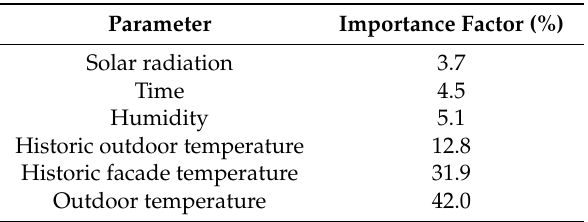
Table 3. Analysis of the relevance of input